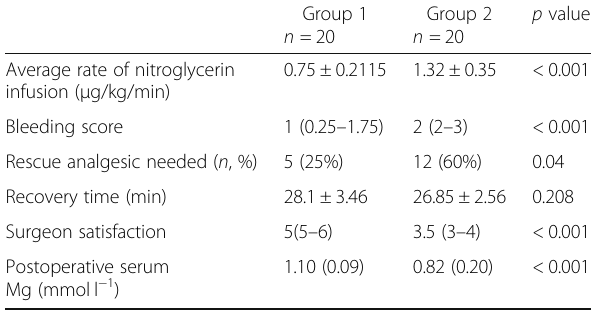
Table 2 Operative and postoperative